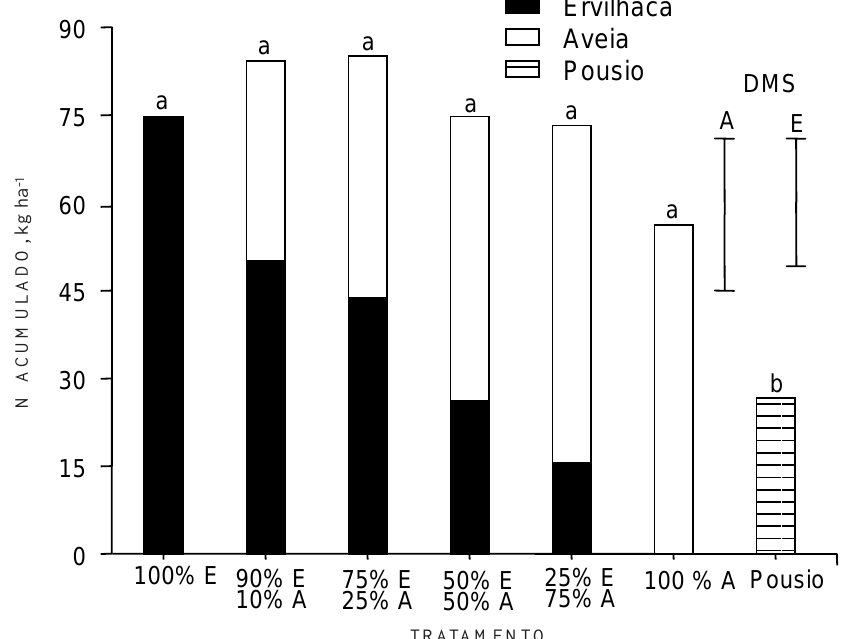
Figura 1. Nitrogênio acumulado pela parte aérea da ervilhaca (E) e aveia (A), na época da floração e vegetação espontânea (pousio). As médias para as quantidades totais de N acumulado, seguidas das mesmas letras, não diferem entre si (Tukey a